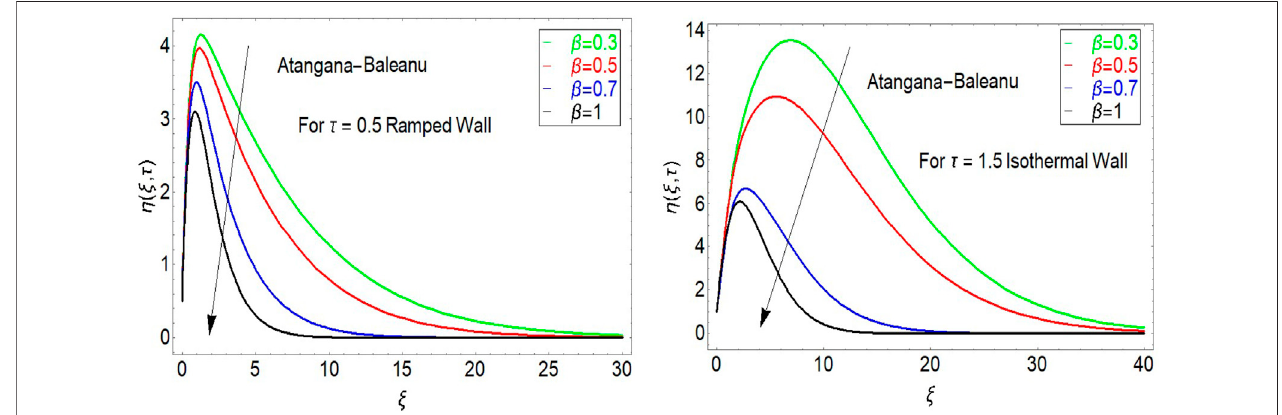
FIGURE 1 | In fl uence of the AB fractional operator on velocity for ramped and isothermal wall temeprature.